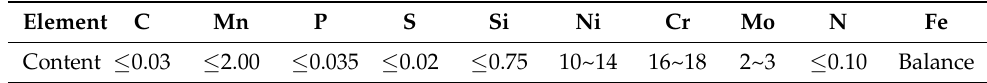
Table 1. Chemical compositions of 316L stainless steel (wt.%).